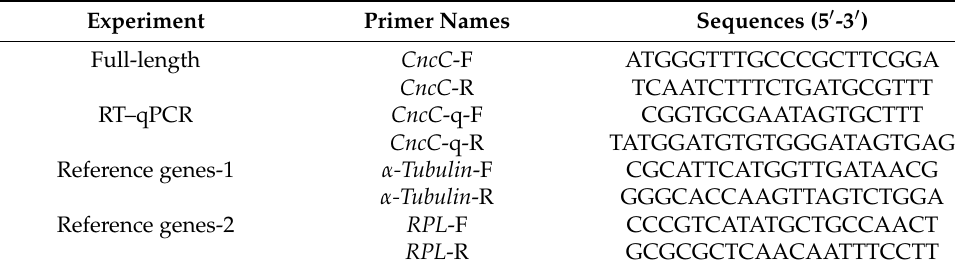
Table 1. Primers used for BdCncC in the